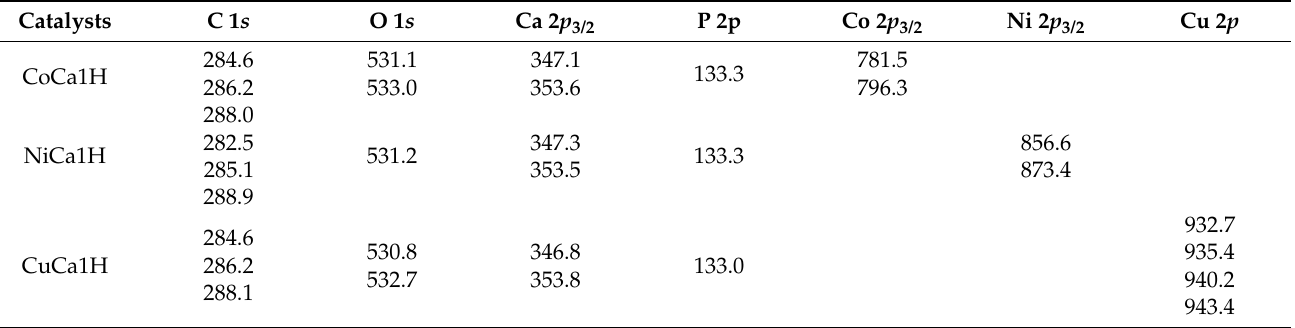
Table 3. Binding Energies values (eV) of the C 1 s , Ca 2 p 3/2 , O 1 s , P 2 p , Cu 2 p 3/2 , and Ni 2 p 3/2 core levels for the spent catalysts tested after recycling